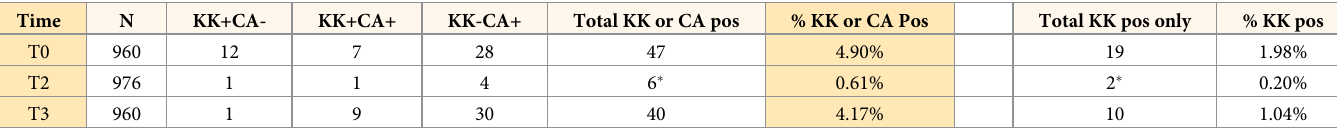
Table 4. Results of faecal testing for taeniasis during a pilot control program for T . solium in Madagascar. Results of Kato-Katz and copro-antigen tests on faecal sam- ples before (T0), after the final round of MDA (T2) of the 3-year pilot project, and one year later (T3). Results are shown for the 20 total villages surveyed.